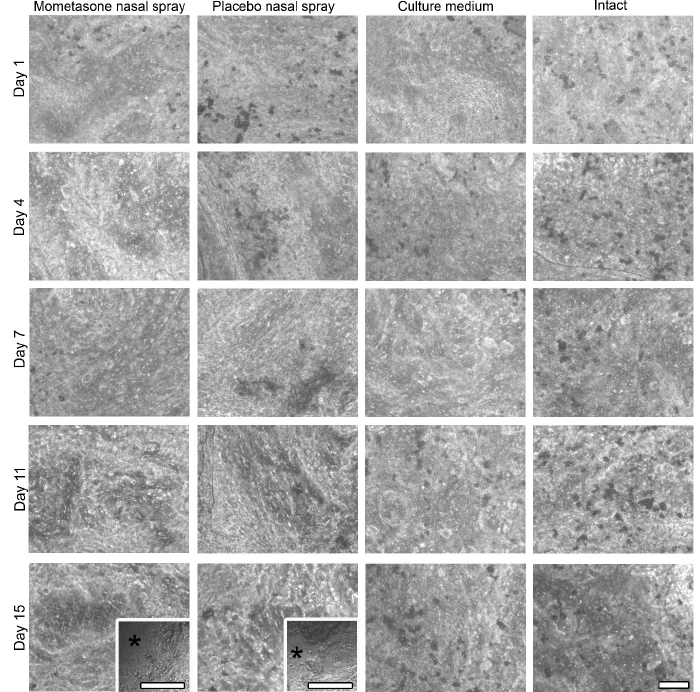
Figure 5. Morphological assessment of the nasal MucilAir TM in vitro models treated with 10-fold diluted mometasone or placebo nasal spray, culture medium treated or untreated for 14 consecutive days using phase-contrast microscopy. The apical surface view is shown. Cell shedding is observed only at the periphery in the mometasone- and placebo-treated nasal MucilAir TM in vitro models on the last 2 days of the experiment (inserts, day 15). Asterisks indicate areas without cells. Scale bars, 100 µm.